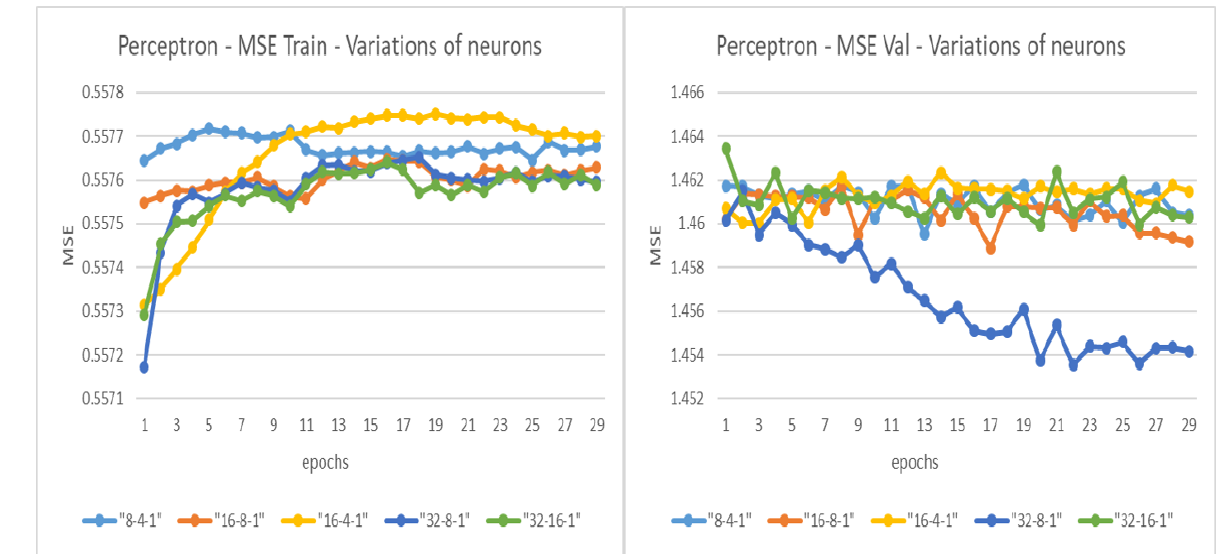
function for the input layer and the hidden layer, and on the other hand the function of the output layer. Soc. Sci. 2021 , 10 , x FOR PEER REVIEW